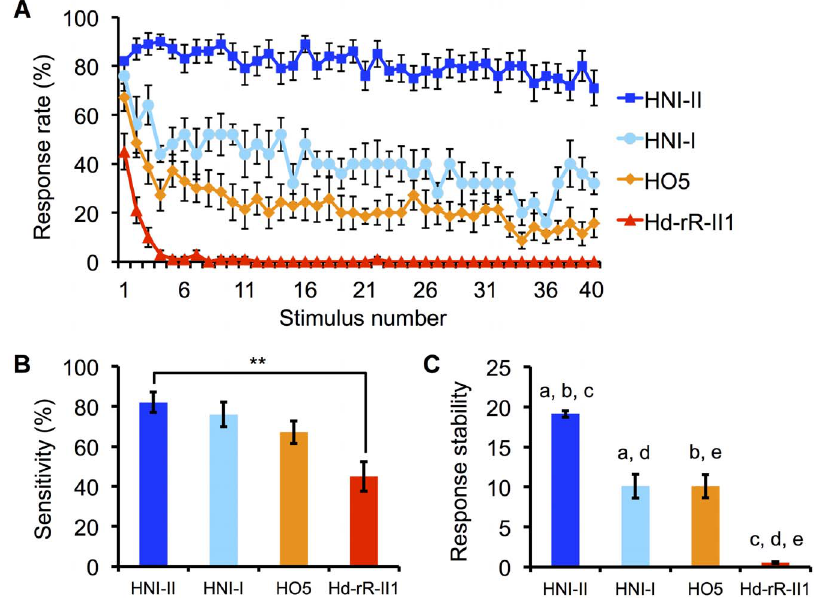
Figure 2. Comparison of Startle Response Properties among Inbred Strains. HNI-II (n=20), HNI-I (n=6), HO5 (n=14), Hd-rR-II1 (n=20). (A) Transition of response probability. Bars represent SEM. (B) Sensitivity of four inbred strains. Bars represent SEM. ** p , 0.01 by Scheffe’s F test. (C) Response stability index of four inbred strains. Bars represent SEM. a, b, c, d, and e indicate p , 0.01 by Scheffe’s F test.